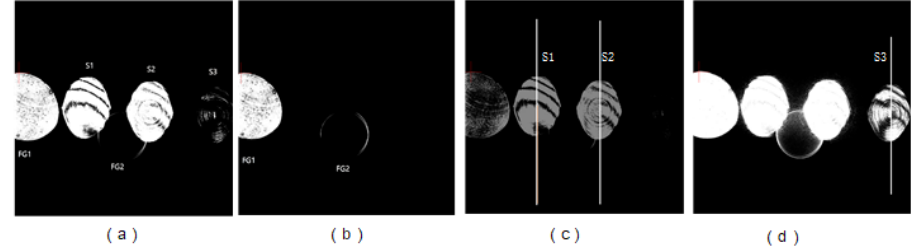
Figure 7. MFI patterns: ( a ) original image with resolution of 2048 × 2048; ( b ) Inherent patterns introduced by the PBS; ( c ) Contrast enhancement for S2; ( d ) Contrast enhancement for S3.